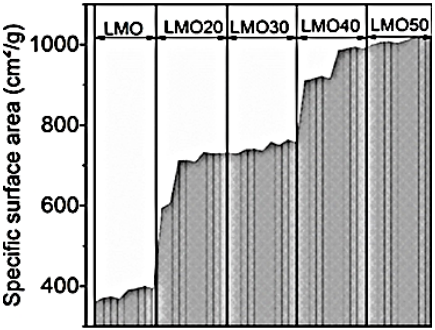
Figure 19. LMO particles size distribution in individual fractions according to the laser diffraction method: The specific surface area of particles in different samples.